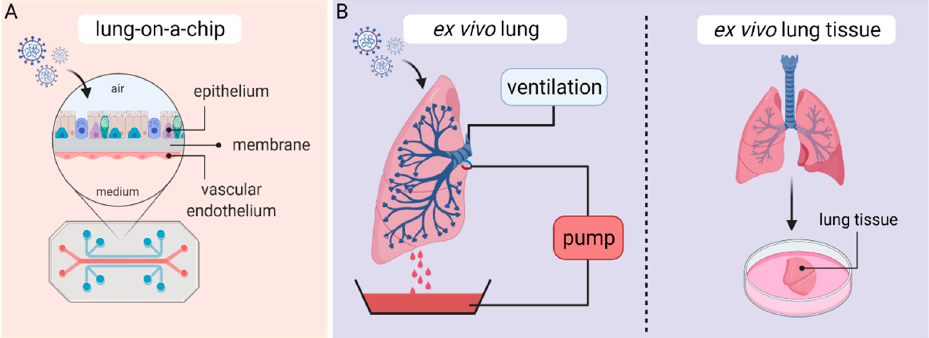
Figure 4. Lung-on-a-chip ( A ) and ex vivo ( B ) culture techniques. Figure was created with BioRen- der.com (accessed on